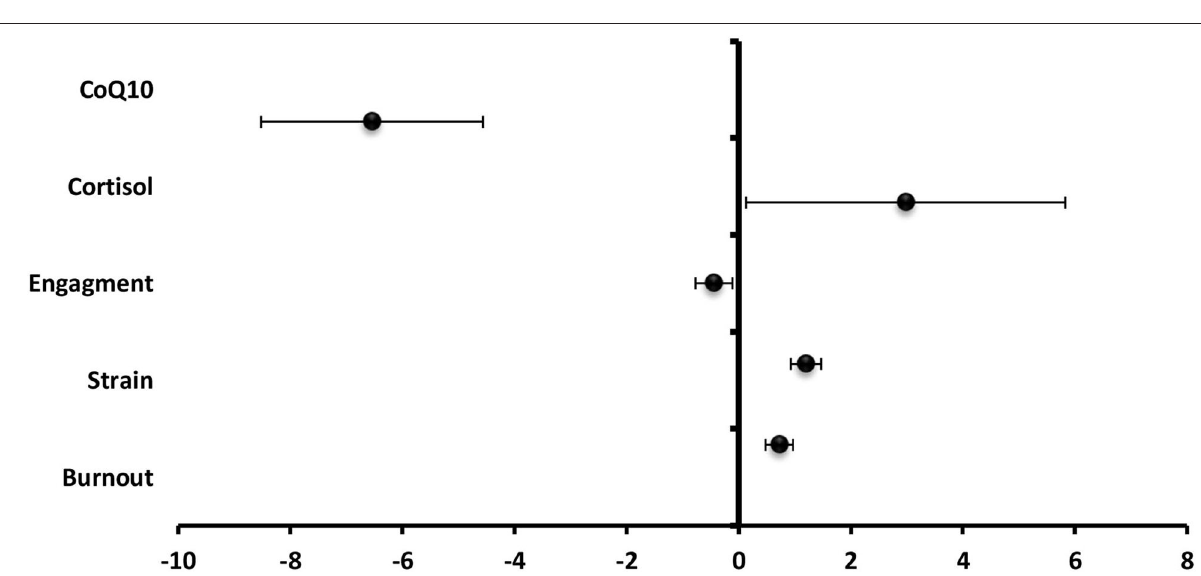
FIGURE 9 | Values of β and CI 95% for linear regression analysis of total techno-stress score as a predictor to biomarkers, burnout, strain, and engagement among